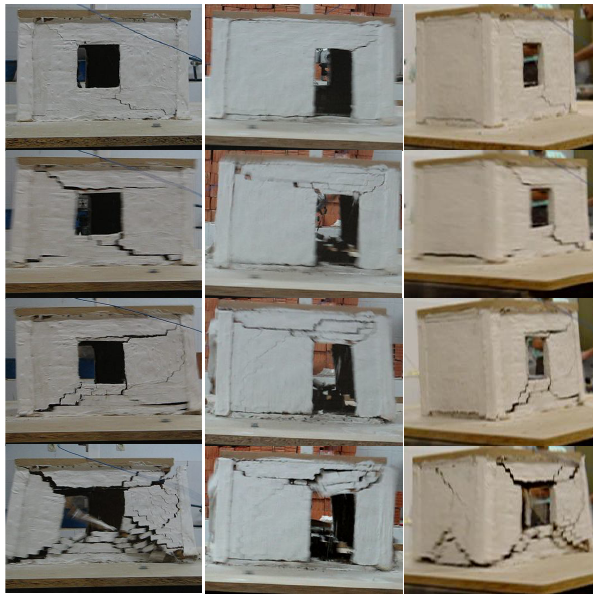
Fig. 21 Damage conditions of specimen SM